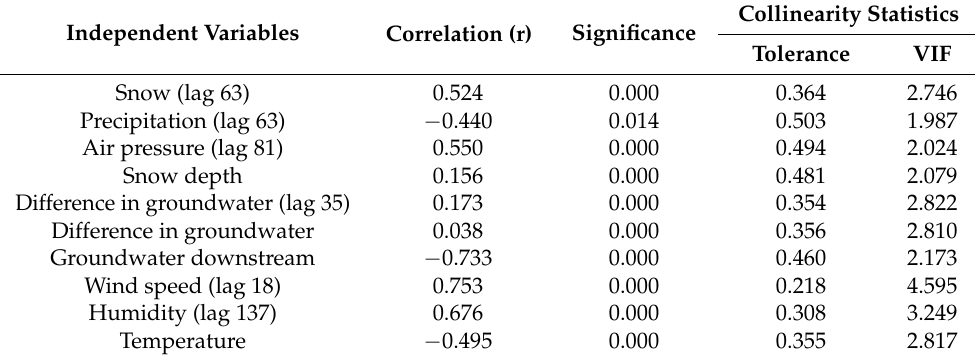
Table 2. The correlation coefficient (r) values are reported for the long-term component between the water discharge and the predictor variables. The second column is the significance level for each predictor variable derived from the TSR model, the third column the collinearity tolerance, and the fourth column describes the variance inflation factor (VIF). The lag values are indicated within the parentheses.